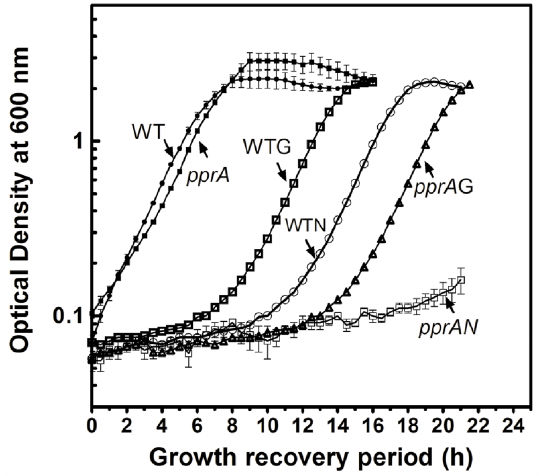
Figure 2. PprA promotes D.radiodurans growth following DNA damage. D. radiodurans (WT) and a pprA::cat mutant (pprA) were treated with nalidixic acid (20 m g/ml) for 2 h (WTN, pprAN) and c radiation (6 kGy) (WTG, pprAG). These cells were washed and resuspended in fresh TGY medium, and growth at 30 u C was monitored as optical density 600 nm.